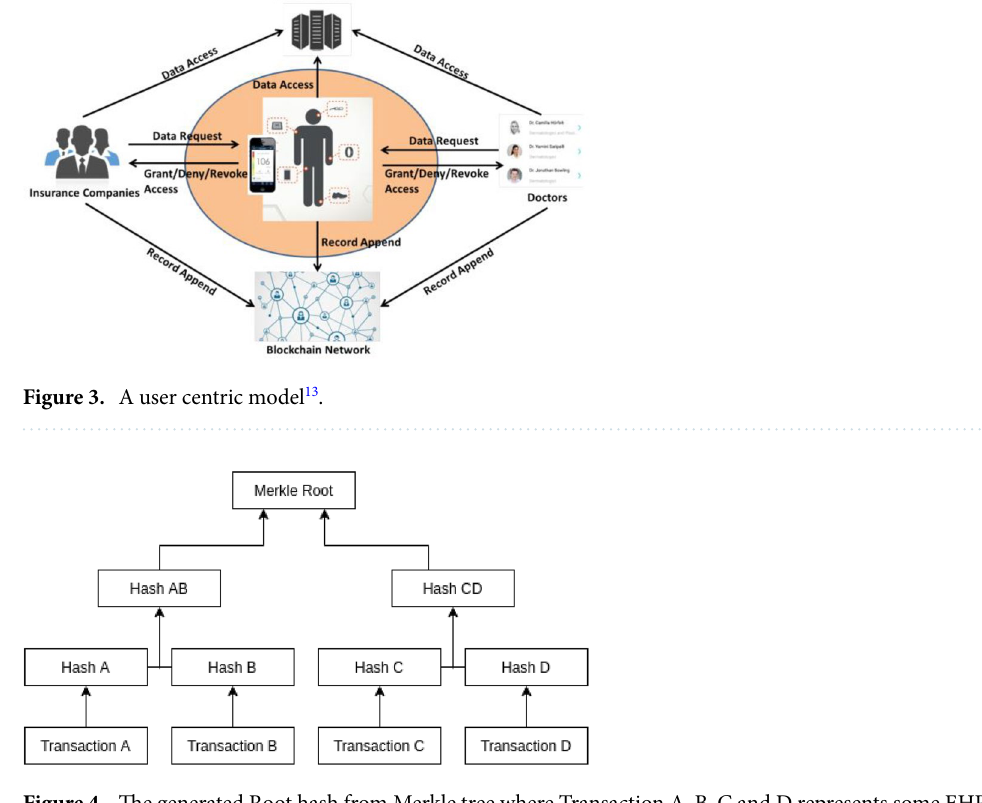
Figure 4. The generated Root hash from Merkle tree where Transaction A, B, C and D represents some